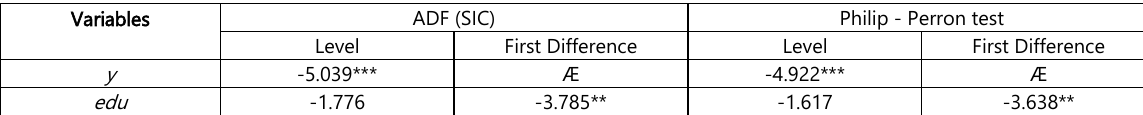
Table 1: Unit Root Tests Results (Source: Author’s calculations)